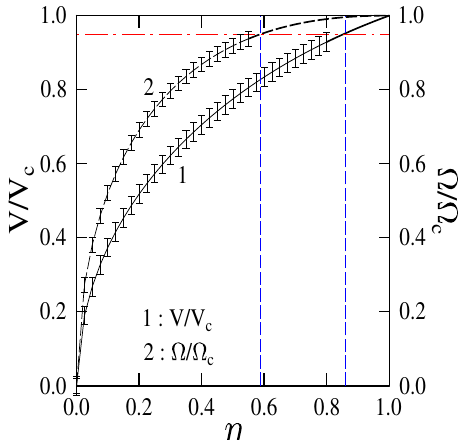
Figure 19. Angular velocity ratio Ω / Ω c as a function of η . The uncertainty bars indicate differences for masses and ages in the main-sequence phase. It is shown that the Ω / Ω c (cid:39) 0.95 (red line) iden- tifies the force ratio η (cid:39) 0.6. The ratio V / V c (cid:39) 0.95 (red line) corresponds to η (cid:39) 0.86. Adapted from Zorec et al.